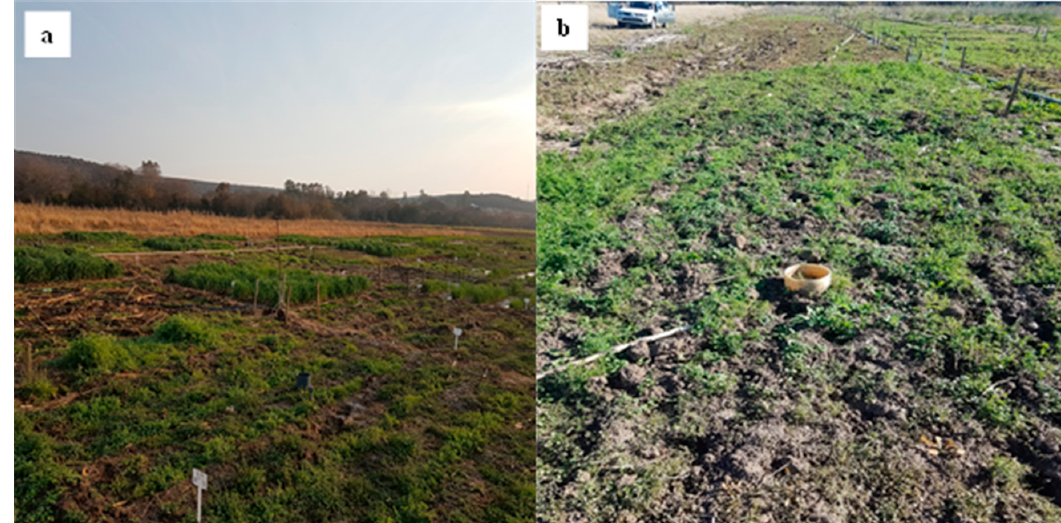
Figure 7: Picture showing (a) slow growth of grazing vetch cover crop relative to oat and (b) Figure 7. Picture showing ( a ) slow growth of grazing vetch cover crop relative to oat and ( b ) grazing grazing vetch crop after damage by cattle. vetch crop after damage by